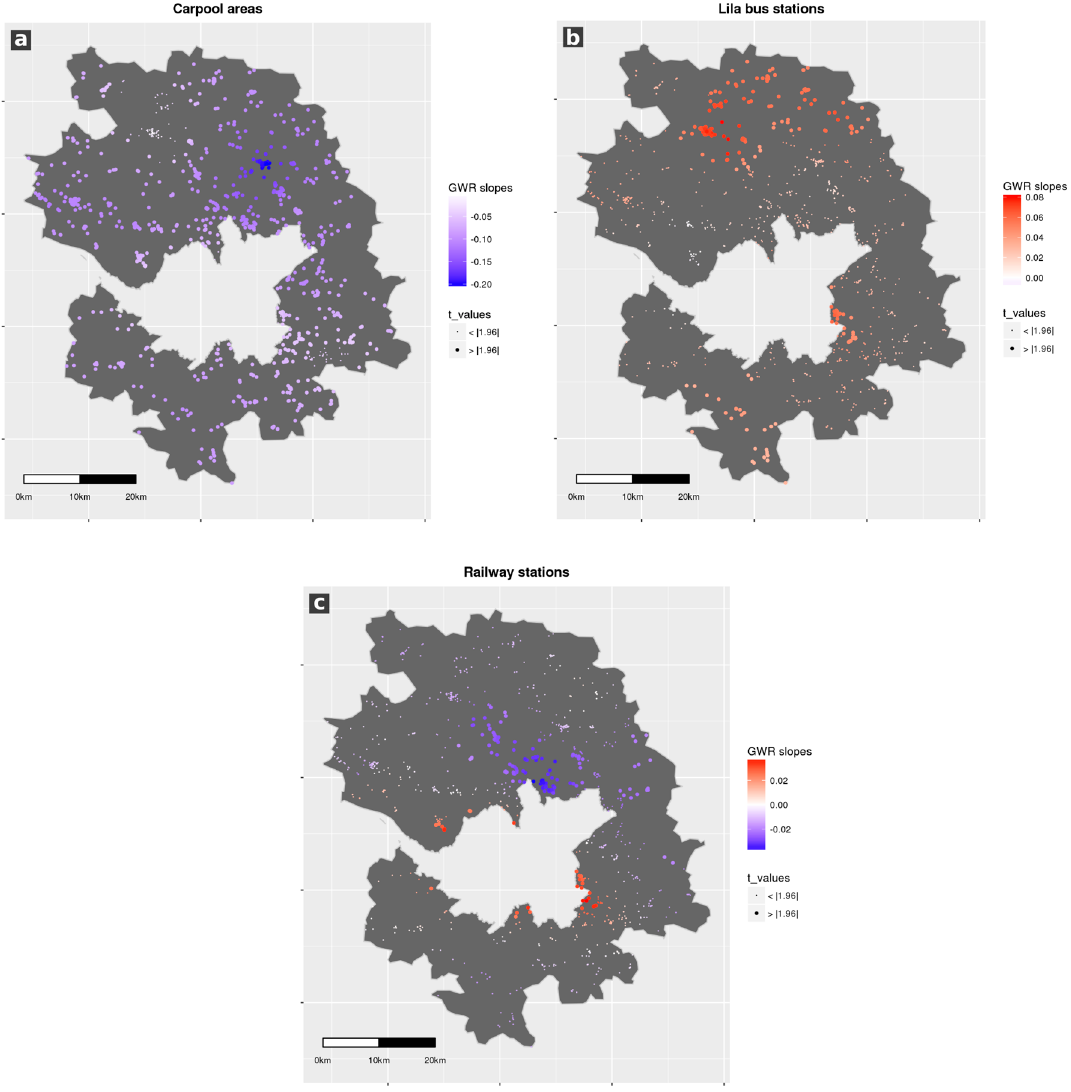
Figure 4. Map of GWR slopes in periurban and rural areas. ( a ) Carpool areas; ( b ) “Lila” bus stations; ( c ) Railway stations.